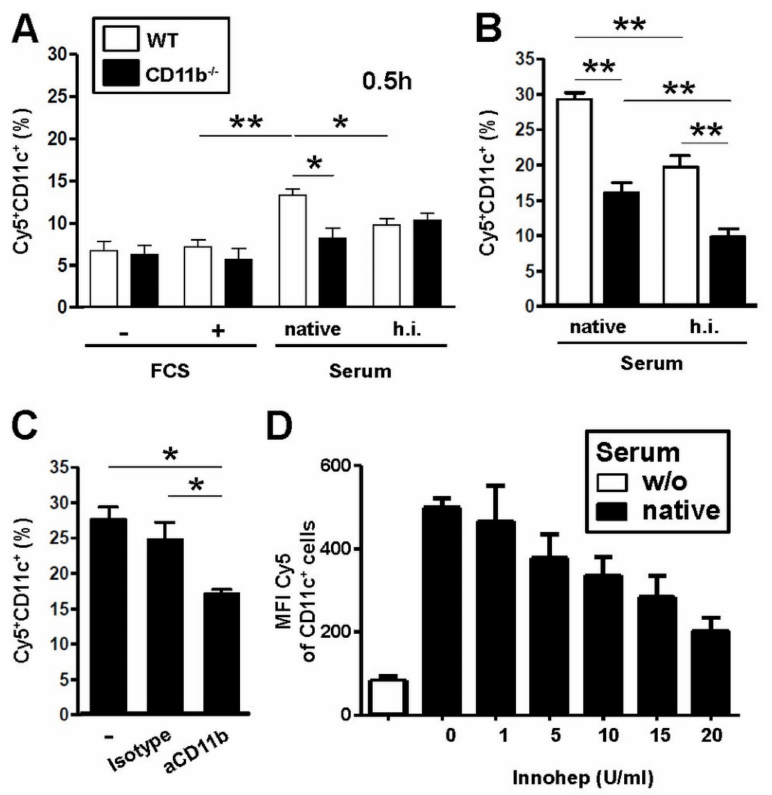
Figure 3. Binding of native serum-pre-incubated solid iron oxide core (FeO-DEX) to BMDC depends on complement activation and CR3 engagement. ( A , B ) BMDC differentiated from bone marrow progenitors derive from wild type (WT), and CD11b − / − mice were incubated with differentially pretreated (left untreated (w/o), pretreated with native or heat-inactivated (h.i.) serum) FeO-DEX as indicated. ( A ) BMDC were incubated with non-pretreated FeO-DEX (BMDC kept in parallel in fetal calf serum (FCS) free ( − ) or standard culture medium (+) and with native and h.i. serum- pre-incubated FeO-DEX (BMDC kept in FCS-containing media) as indicated. After 0.5 h, frequencies of Cy5 + BMDC (CD11c + cells) were assessed by FACS analysis (mean ± SEM of 3 experiments). ( B ) WT and CD11b − / − BMDC were mixed and incubated for 4 h with FeO-DEX pre-incubated with native or h.i. serum. Frequencies of Cy5 + BMDC were assessed by FACS analysis (mean ± SEM of 3 experiments). ( C ) WT BMDC were pretreated in parallel with blocking anti-CD11b and a corresponding isotype control antibody, followed by incubation with native serum-pre-incubated FeO-DEX applied 45 min later. Frequencies of Cy5 + BMDC were assessed after 3 h by FACS analysis. ( D ) Native serum was pre-incubated in parallel with increasing doses of complement blocking heparin (Innohep) for 10 min. FeO-DEX were added, and samples were incubated for 1 h. Pretreated FeO-DEX were applied to WT BMDC, and after 4 h, Cy5 MFI of DC (CD11c + ) were monitored (mean ± SEM of 3 experiments). ( A – C ) Statistical differences between groups are indicated (one-way ANOVA, Tukey’s test). * p < 0.05, ** p <